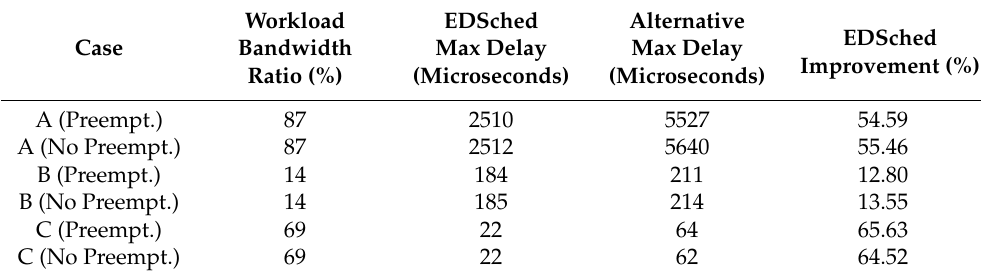
Table 2. EDSched max end-to-end delay improvement for ED